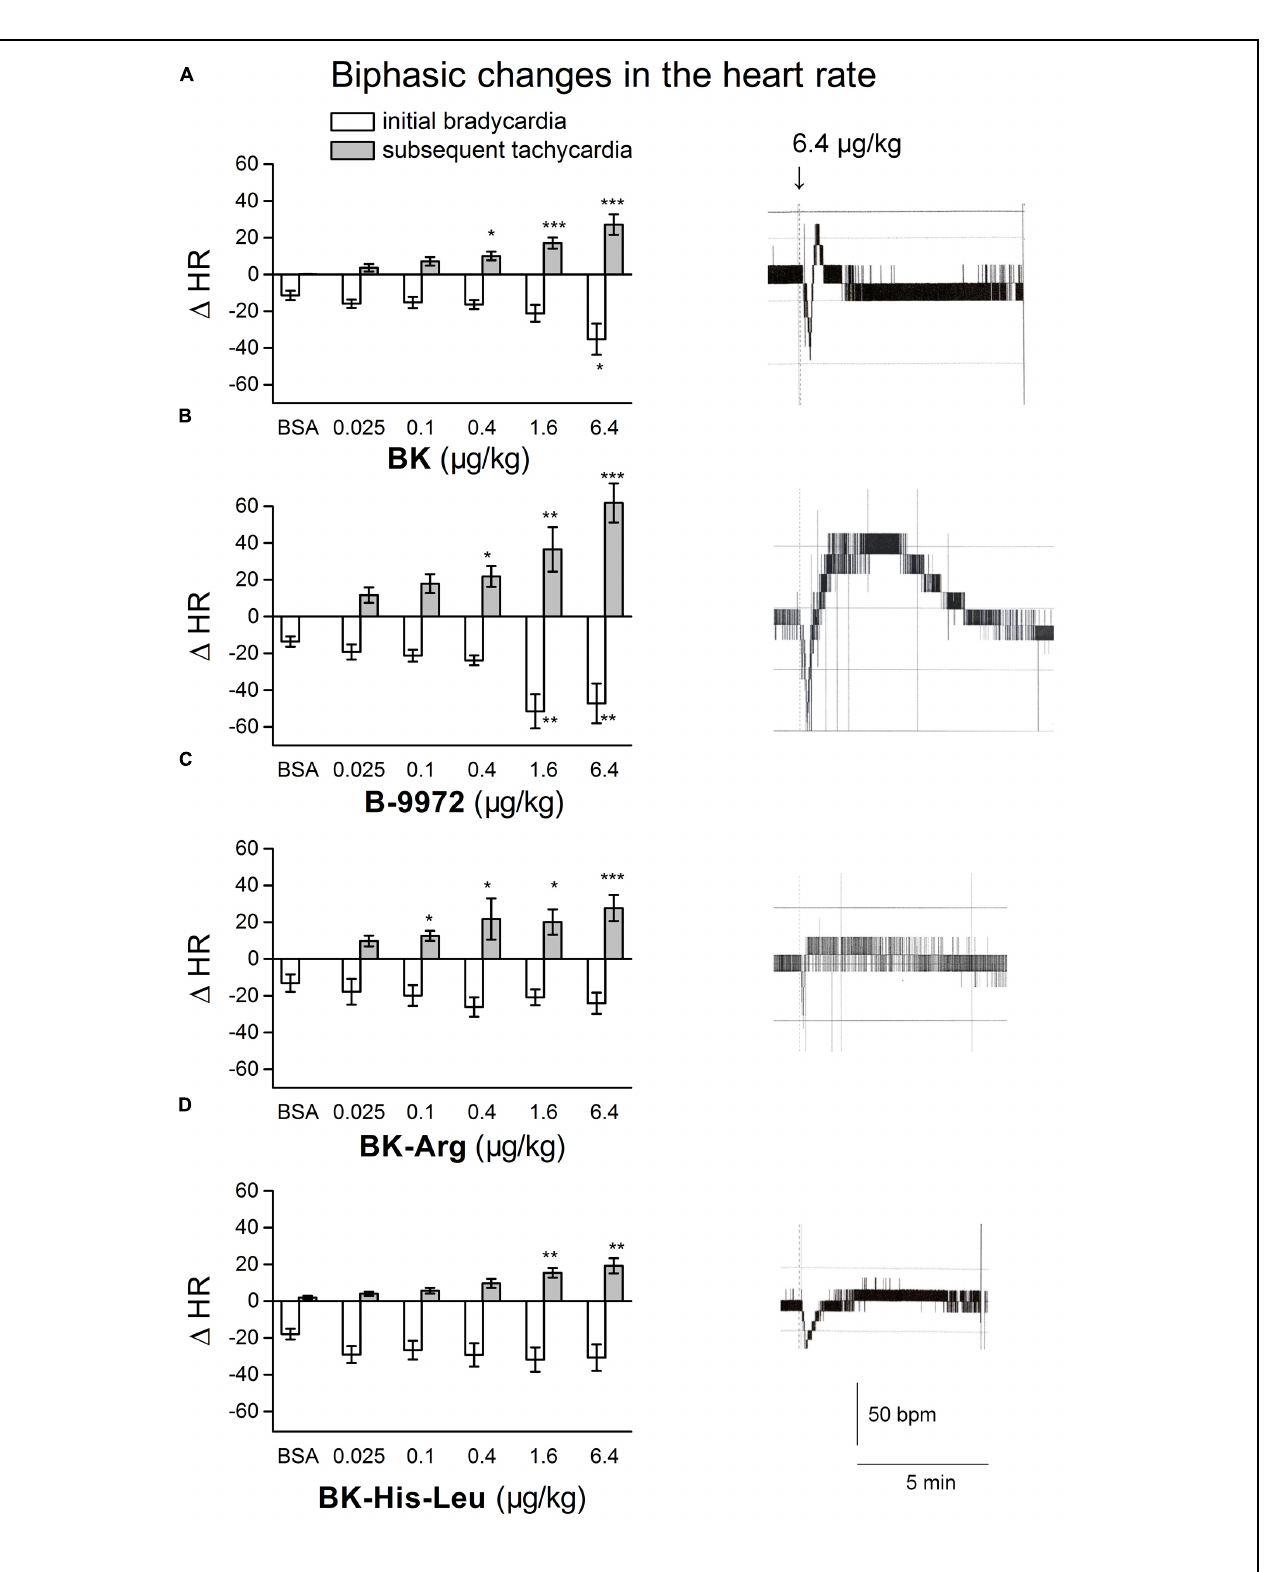
FIGURE 3 | Bar graph showing maximal changes in heart rate (HR) elicited by i.v. injections of vehicle, and increasing doses of (A) BK ( n = 10), (B) B-9972 ( n = 7), (C) BK-Arg ( n = 11), and (D) BK-His-Leu ( n = 10) in anesthetized rats. On the right side of each graph are presented typical tracings showing the changes in HR elicited by the highest dose of the agonist tested. Abscissa: dose ( µ g/kg); ordinate: rises of HR (bpm). Values are means ± SEM. ∗ P < 0.05; ∗∗ P < 0.01; ∗∗∗ P < 0.001 compared with vehicle value (Dunnett’s test).